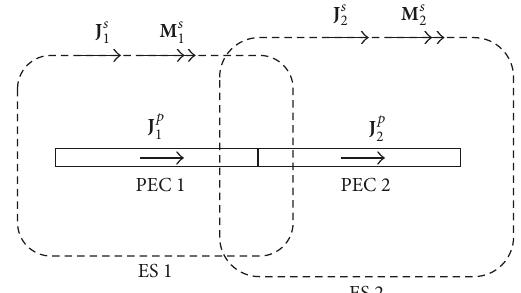
Figure 4: A PEC strip solved using source reconstruction